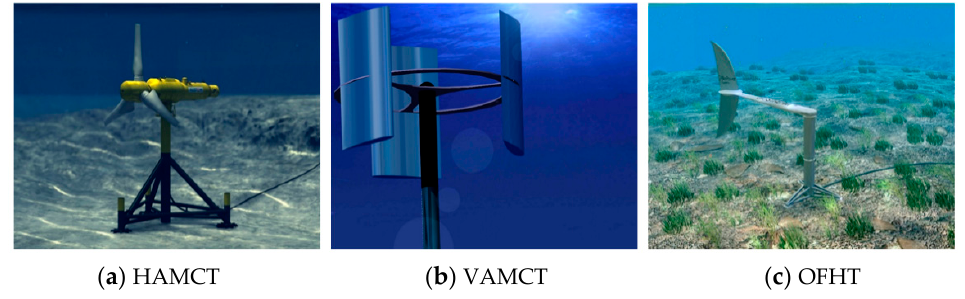
Figure 1. Hydrokinetic turbines.